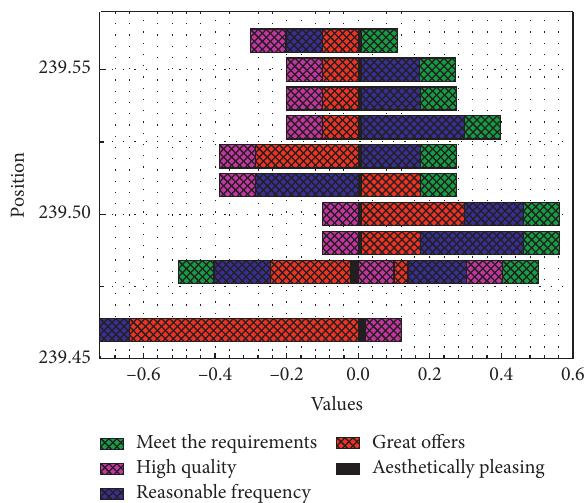
Figure 4: Statistics that meets the needs of